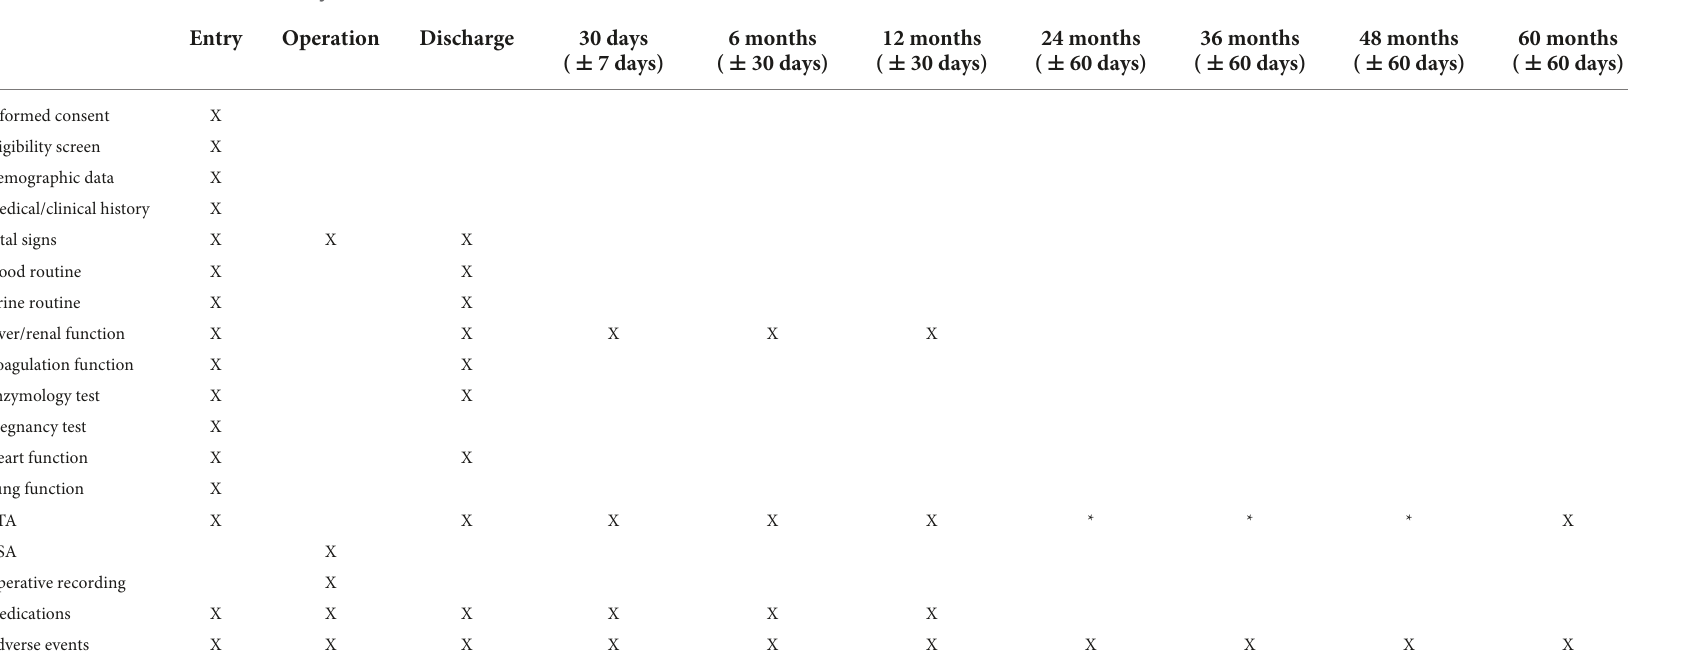
TABLE 3 Evaluation schedule of the